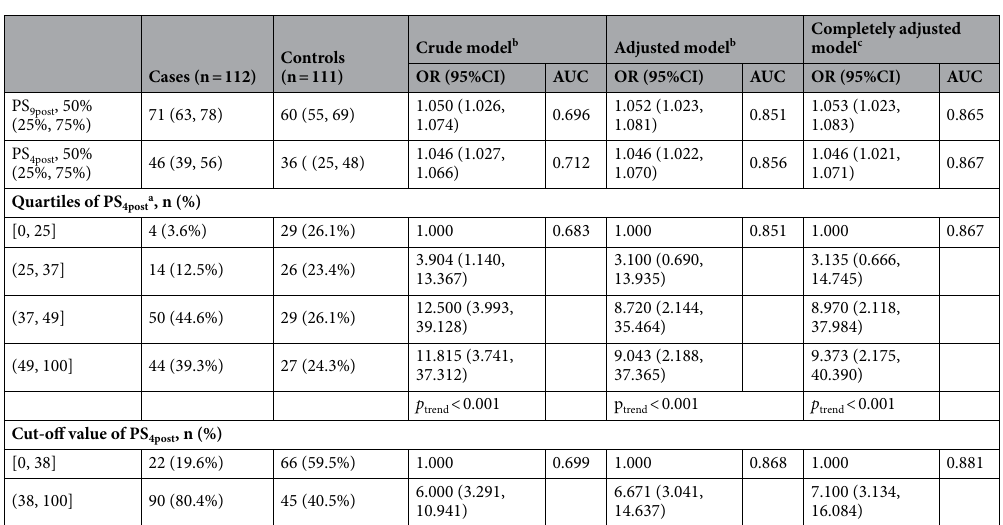
Table 3. The association between PS9post or PS4post and the risk of postmenopausal breast cancer. a Defined by the quartile level in the control group. b Crude model: Only the score, without other environmental risk factors. Adjusted model: Adjusting residence, education, income, occupation, passtive smoking, adverse pregnancy history, abortion history, energy intake and estrogen disease. c Completely adjusted model: Adjusting WHR further. The sensitivity was 0.65, specificity was 0.68, positive predictive value was 0.68, negative predictive value was 0.66 and accuracy was 0.67 when only PS 4post was included. The number of proteins significantly different between groups was 4 of the postmenopausal subjects, so the two scores were recorded as PS 9post and PS 4post